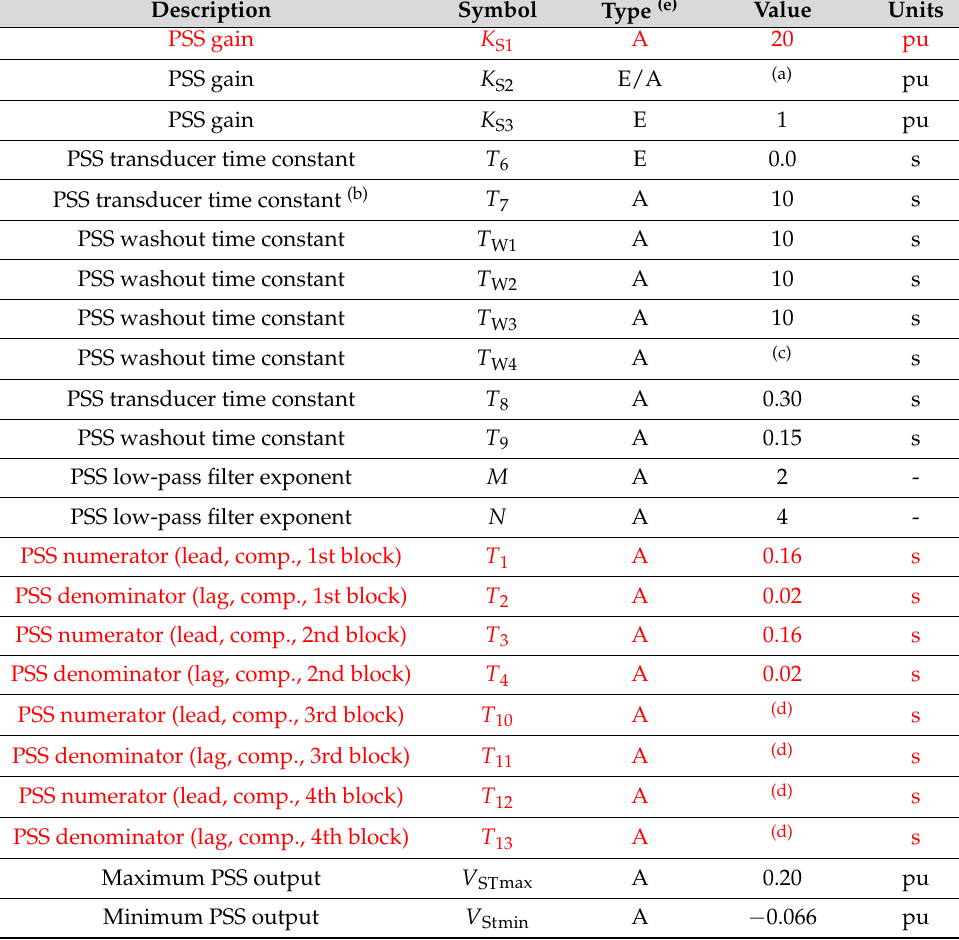
Table 1. Sample data (settings) for PSS2C stabilizer for ST1C model [18].